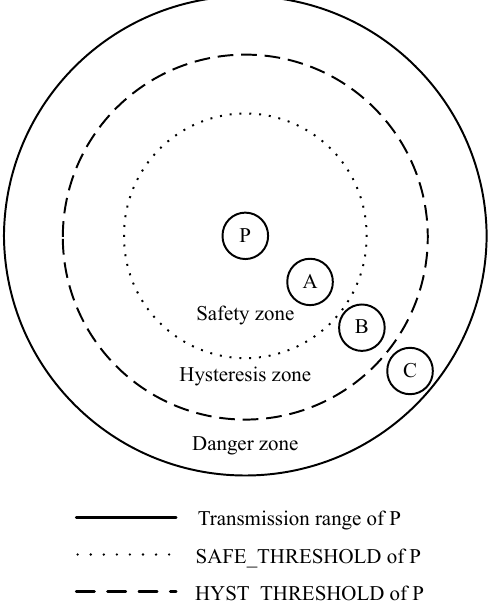
Figure 1. Node P is the parent node of nodes A, B, and C. A is in the Safety zone of node P. B is in the Hysteresis zone of node P. C is in the Danger zone of node